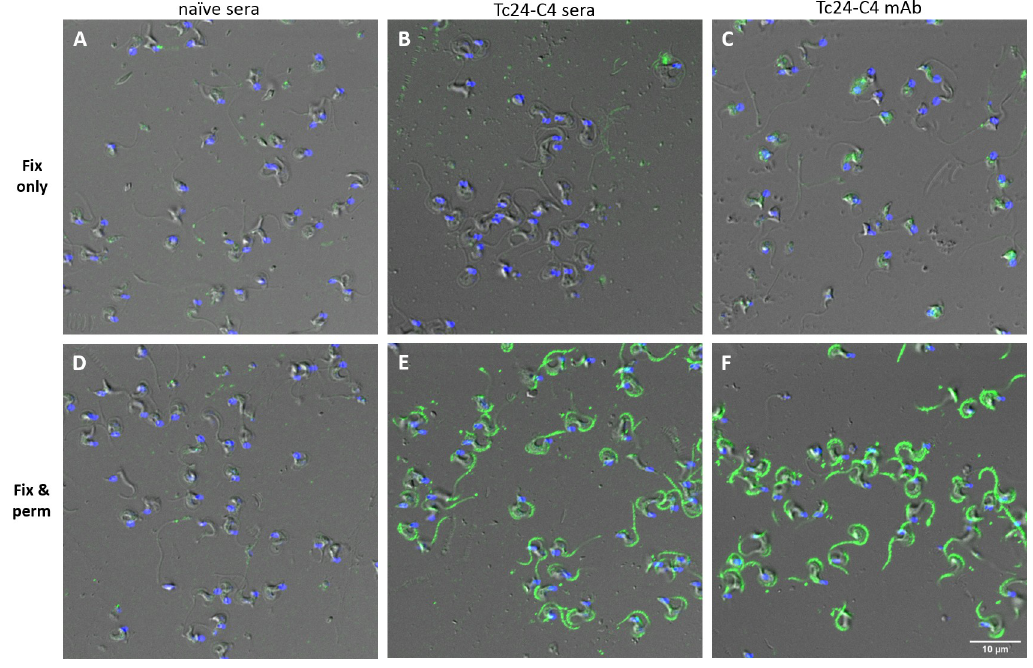
Fig 3. Antibodies recognizing Tc24 binds strongly to fixed and permeabilized T . cruzi trypomastigotes but not to fixed- only trypomastigotes. Staining of fixed-only (fix only) or fixed and permeabilized (fix & perm) T . cruzi trypomastigotes with mAb Tc24-C4/884, Tc24-C4 polyclonal antisera or na ï ve sera followed by staining with goat anti-mouse IgG (H+L) Alexa Fluor 488 (green). After staining DAPI (blue) was used to stain the nucleus and kinetoplast. Pixel size of images: 60 nm x 60 nm.